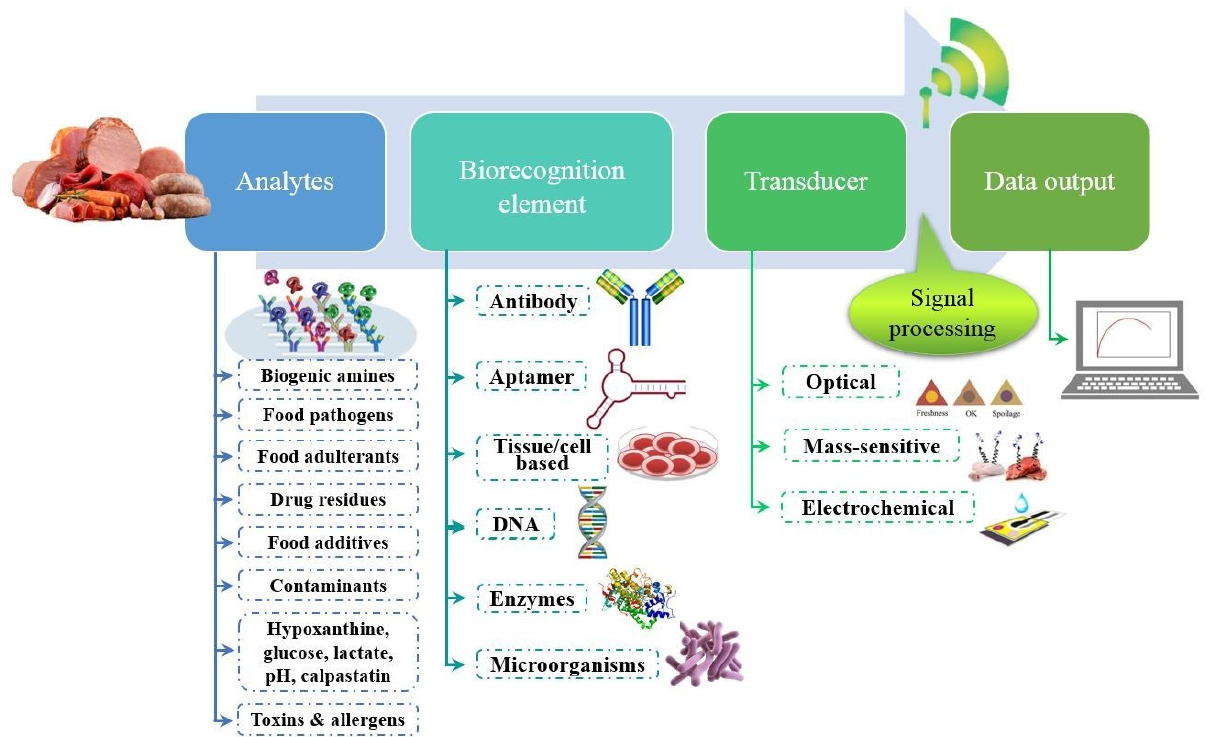
Figure 2. Schematic diagram of the working principle of biosensors for the detection of different analytes from meat and meat products.